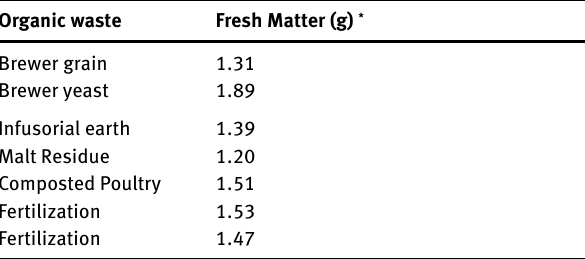
Table 1. Fresh Matter of the cauliflower shoot section treated with different organic waste